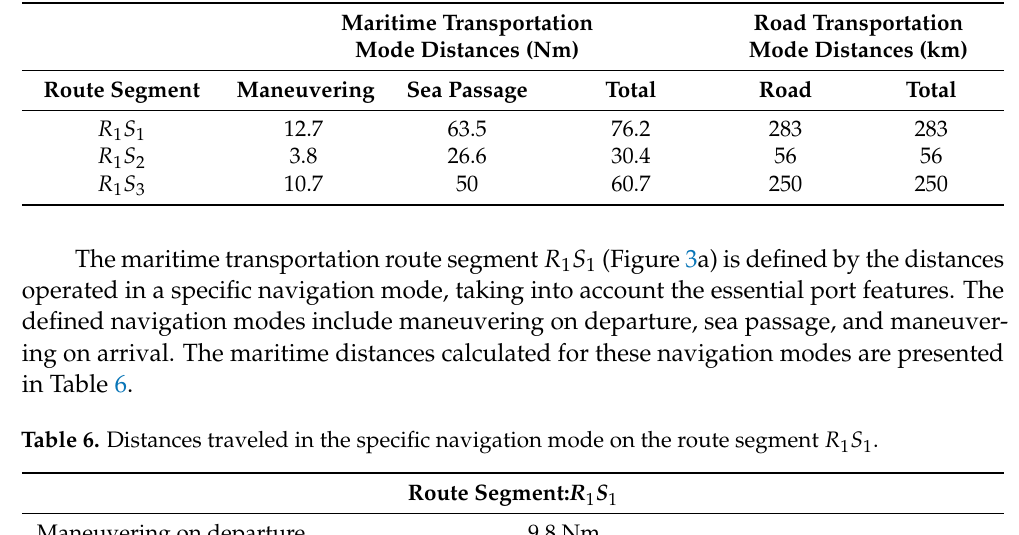
Table 5. Determined distances on route R 1 .